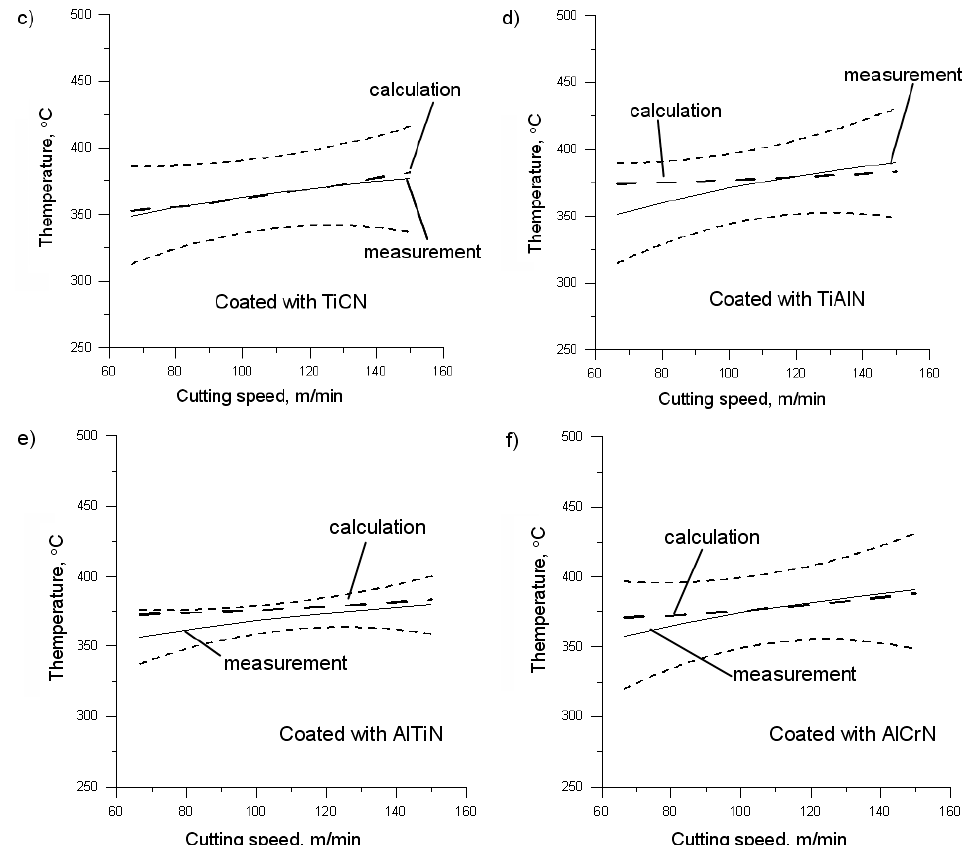
Figure 10. The measured and calculated maximum temperature of the chip surface for the H10F insert uncoated ( a ), coated with TiN ( b ), TiCN ( c ), TiAlN ( d ), AlTiN ( e ), and AlCrN ( f ).